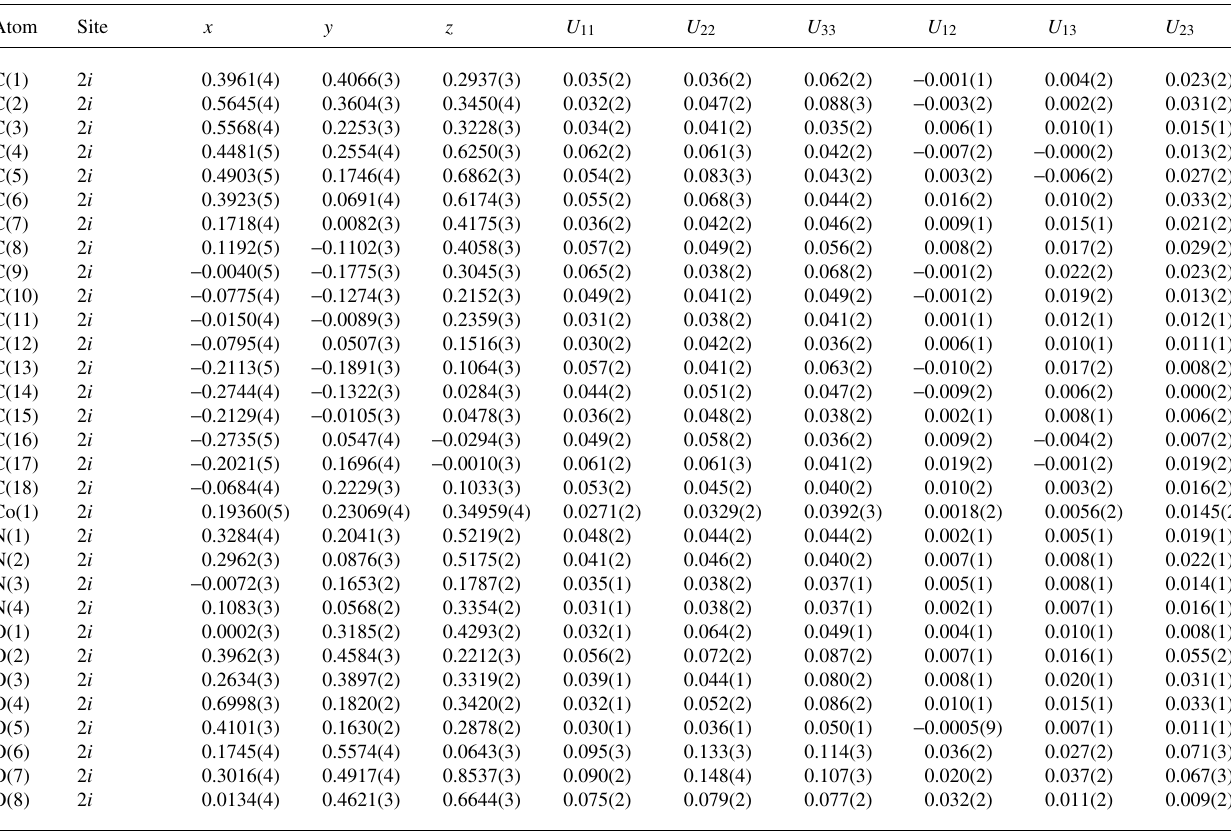
Table 3. Atomic coordinates and displacement parameters (in Å 2 )